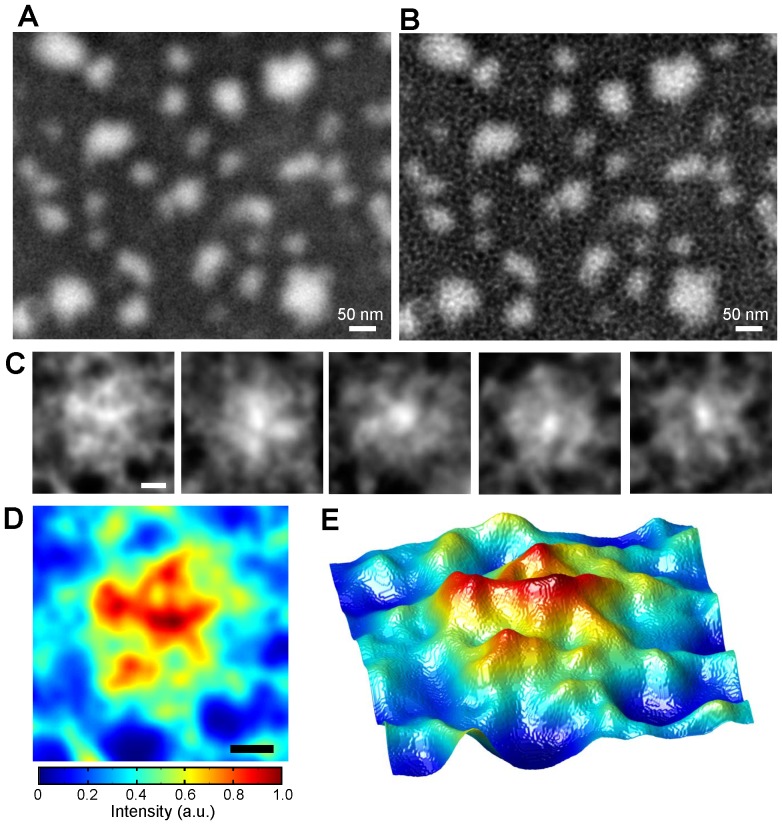
Observation of an unstained IgM antibody.(A) Image of unstained mouse IgM obtained by our method using FE-SEM. The image conditions are as follows: magnification 80,000×, accelerating voltage 3.6 kV EB, application of a 2D Gaussian filter (size 9×9 pixels, σ = 1.5). Many particles of <50-nm diameter are dispersed throughout the area. (B) Super-resolution image of (A) calculated using the Lucy–Richardson deconvolution algorithm. (C) Five individual IgM molecules from the deconvolution images. The molecules are star-shaped pentamers with five IgG arms. (D) Pseudo-colour map of an IgM molecule at the left side of (C). (E) 3D colour map of the same IgM molecule. Note that the five IgG arms are more clearly defined than in the original image. Scale bars: (A) and (B) 50 nm, (C) and (D) 20 nm.